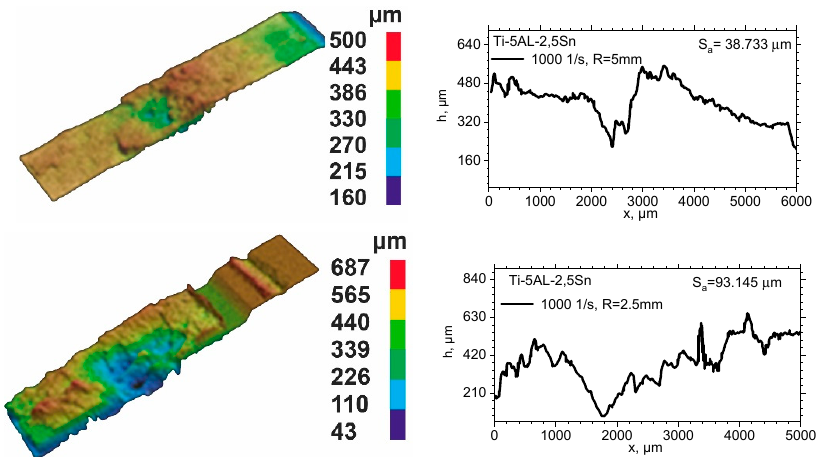
Figure 10. Roughness profiles of Ti-5Al-2.5Sn fracture surfaces. ( Left column ) shows 3D images of the fracture surface profile; ( right column ) shows profiles of height h along a straight line segment parallel to the axis OX and equidistant from the surfaces of the sample along a line equidistant from the sample surfaces.